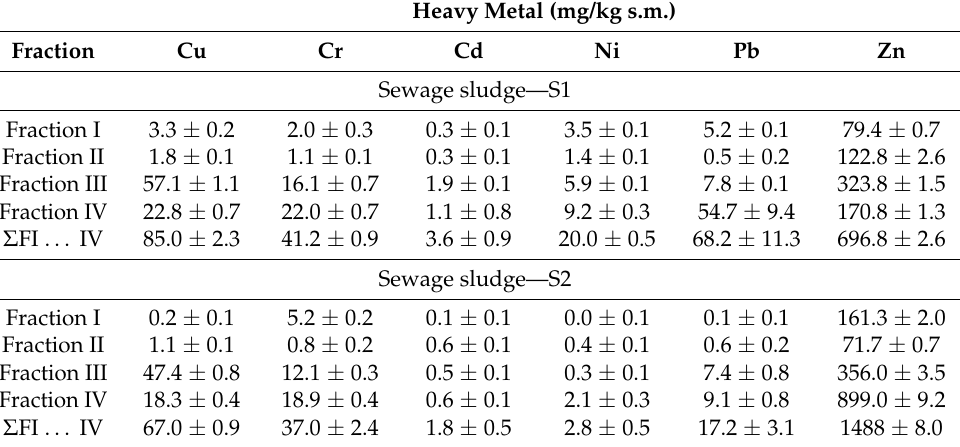
Table 7. Chemical speciation of heavy metal in sewage sludge, for sludge from all four treatment plants, the results are the statistical average of four separate measurements for each sludge, excluding coarse errors, mg · kg − 1